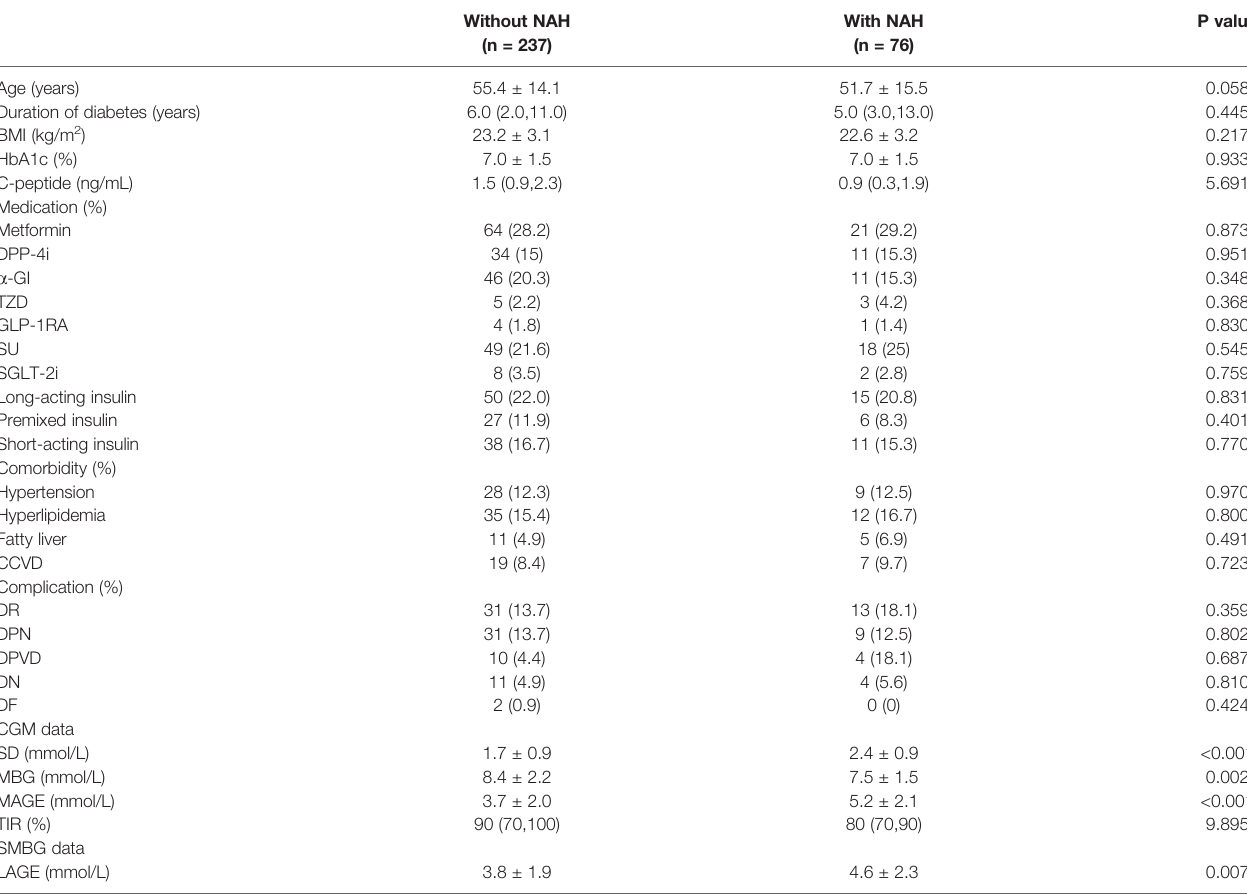
TABLE 1 | Clinical characteristics and blood glucose monitoring results. Without NAH With NAH P value (n = 237)